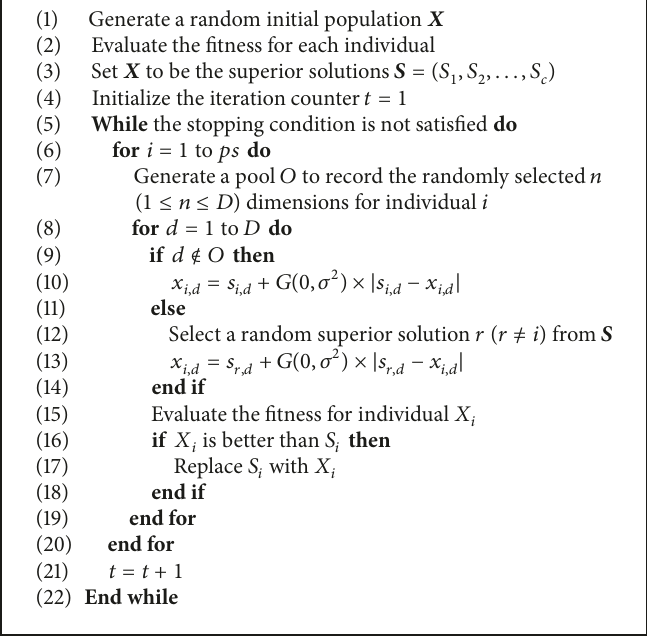
Algorithm 1: The main procedure of